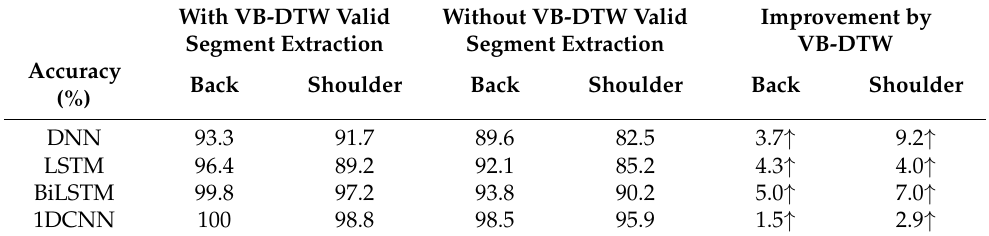
Table 4. Test result of the effectiveness of VB-DTW valid segment extraction. With VB-DTW Valid Segment